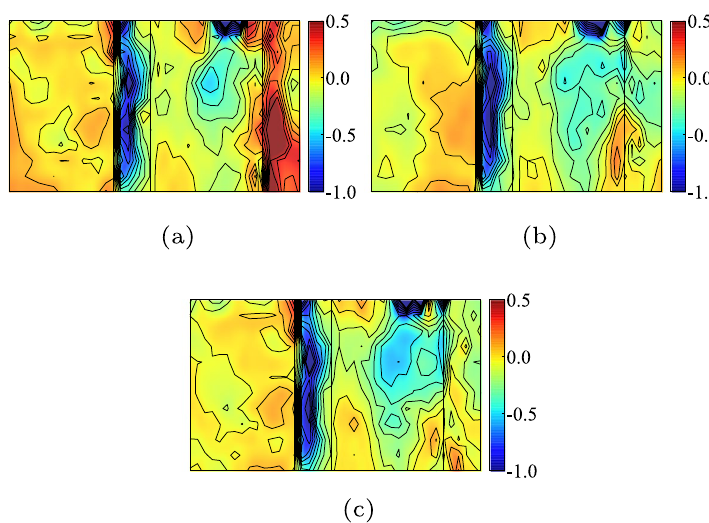
Fig. 18 The surface distributions of the PE ˇ ( c )